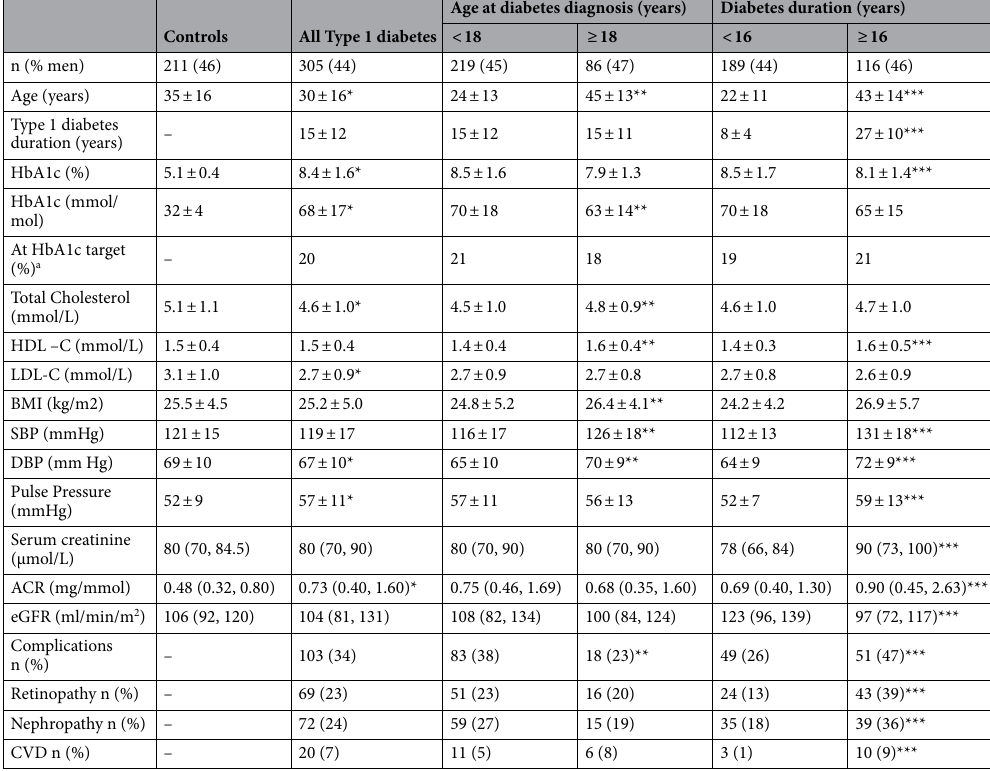
Table 3. Clinical characteristics of participants with and without diabetes in the miRs substudy. Data shown: mean ± SD or median (LQ, UQ). * p < 0.05 versus Controls (CON). ** p < 0.05 versus Age at diabetes adults, ≤ 7.5% (58 mmol/mol) for